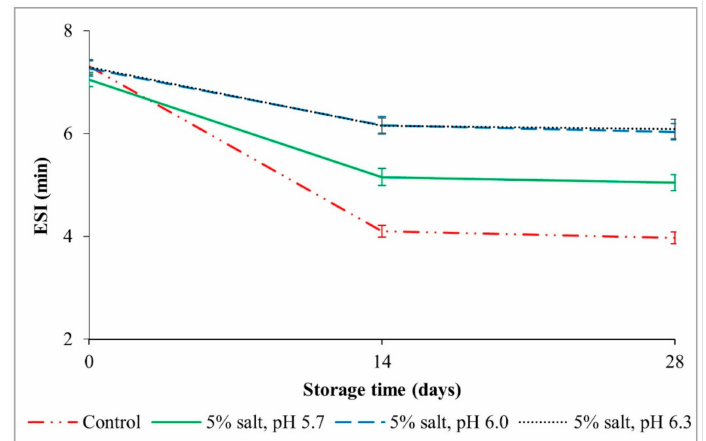
Figure 17. The effect of treatment on the emulsifying stability index (ESI) of frozen-thawed liquid egg yolk. Data are presented with mean ± standard